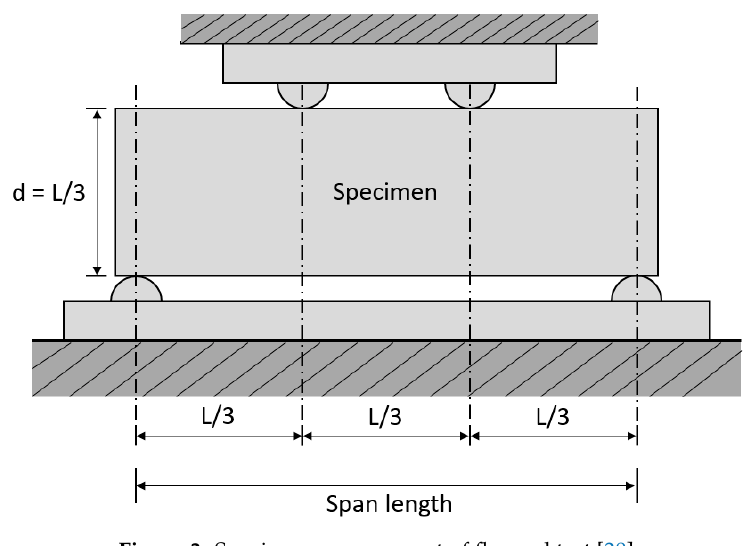
Figure 3. Specimen arrangement of flexural test [30].